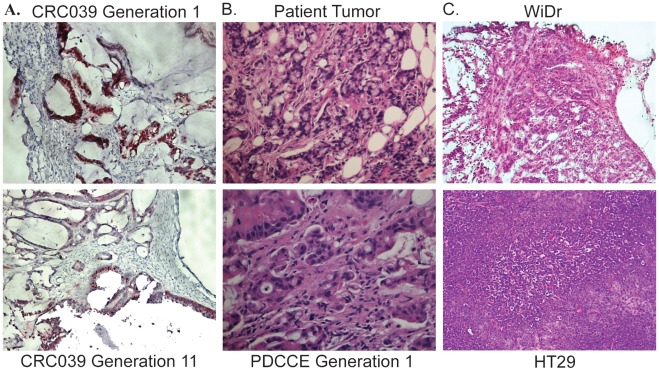
PDCCEs retain nuclear CDX2 expression and signet ring morphology observed in original patient tumors.A. Representative PDCCE (CRC039) retains nuclear CDX2 expression after 11 generations in mice. Images shown are at 20× magnification. B. Early passage PDCCEs retain signet ring morphology observed in original patient colorectal tumor. Images shown are at 40× magnification. C. Xenografts generated from WiDr and HT29 CRC cell lines lack histological features consistent with patient-derived explants including the presence of stroma and the formation of glands. Images shown are at 20× magnification.